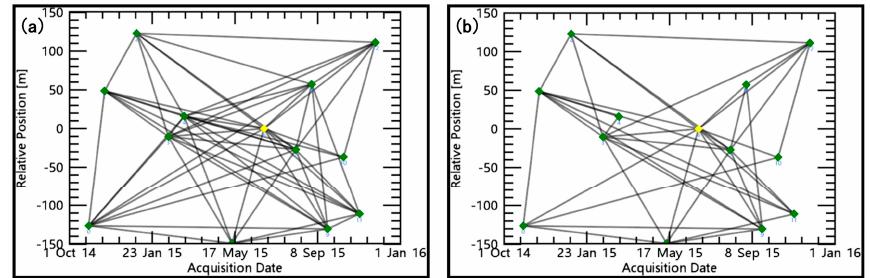
Figure 3. Spatial and temporal baselines of the interferometric pairs. ( x axis represents the temporal baseline, y axis represents the perpendicular baseline, and the yellow solid point represents the selected master image in our data stack) ( a ) Lungui Highway; ( b ) G1501 Highway.